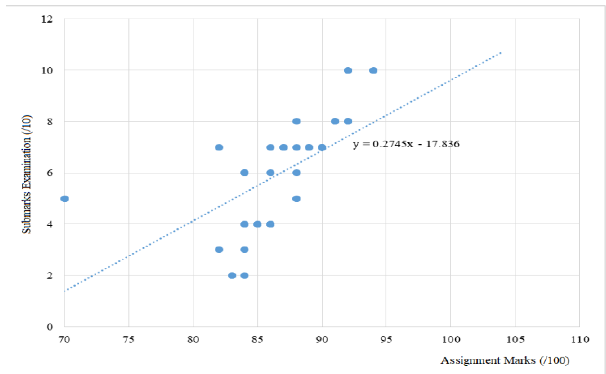
Figure 8: Correlation test between assignment marks